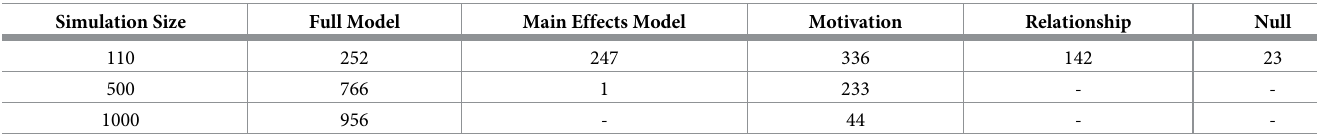
Table 13. Models chosen using change in deviance